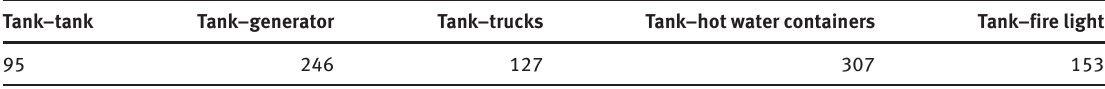
Table 2: Average Distance Between Tank and Other Similar Hot Spot